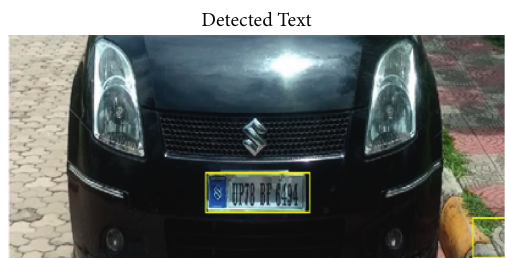
Figure 15: Detected text after letter